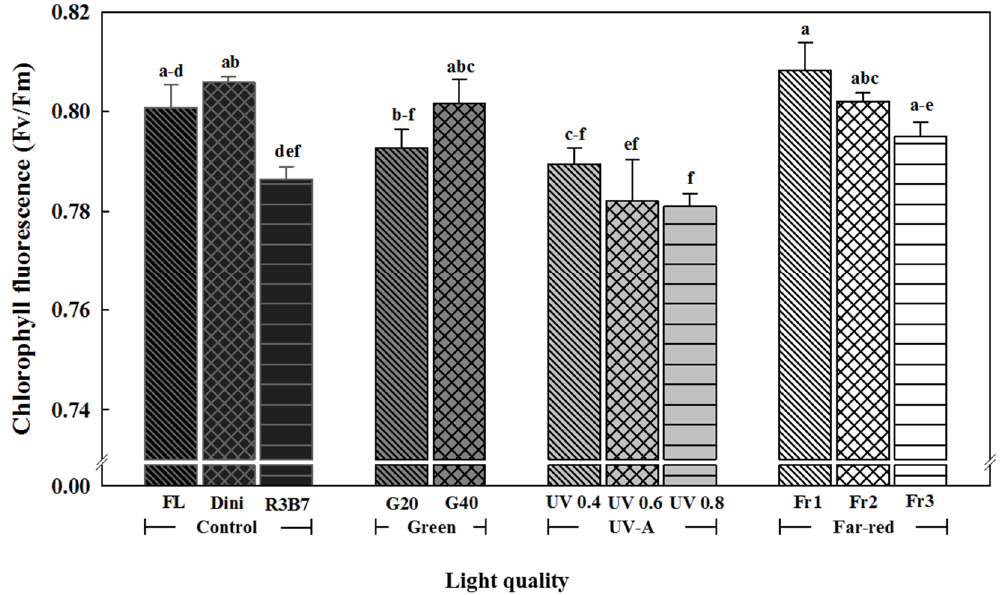
Figure 8. The effects of the light quality on the chlorophyll fluorescence of ‘Mini Chal’ tomato ( Solanum lycopersicum L.) measured 21 days after start of treatment. Refer to Figure 1 for details on the light quality. Vertical bars indicate the mean ± SD ( n = 3). Different letters above bars indicate significant differences by Duncan’s multiple range test at p = 0.05.